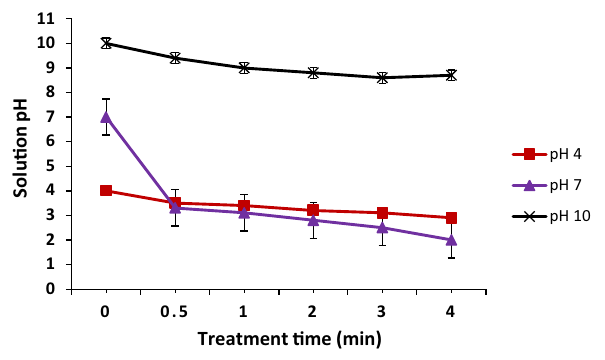
Fig. 9 Effect of input plasma power on removal efficiency (%) of caf- feine in water samples. Initial caffeine concentration: 100 µg/mL; solution volume: 20 mL and initial pH: